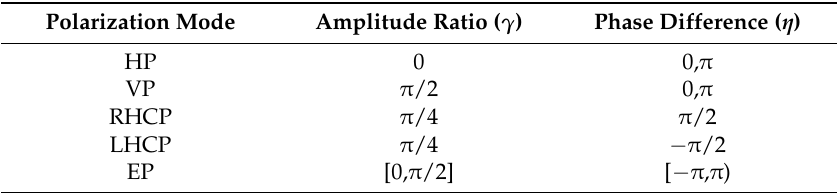
Table 1. Polarized